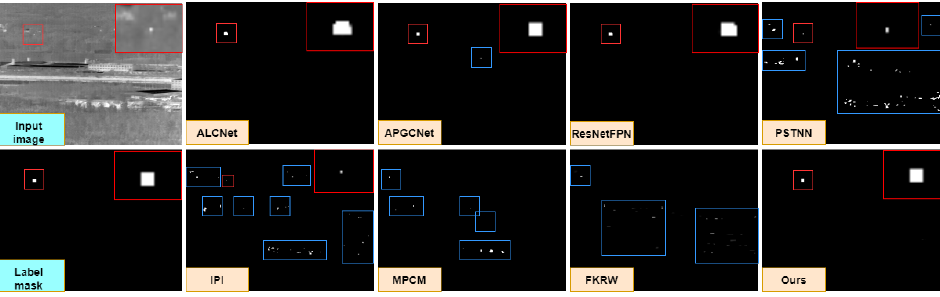
Figure 11. Detection results of infrared small targets in Scene 4 using different detection